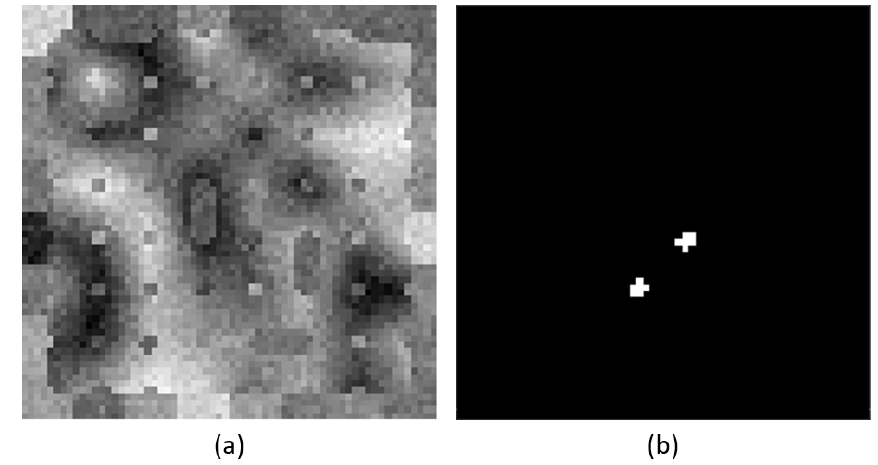
Figure 3. ( a ) The first band of the synthetic hyperspectral image. ( b ) Ground truth location of the